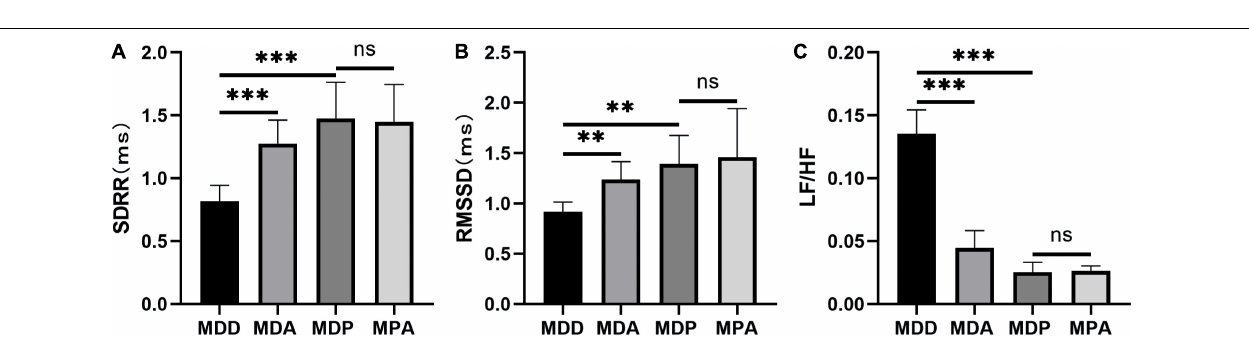
FIGURE 12 | Behavioral measurements. (A) Sucrose preference after CUMS. (B) Immobility time after CUMS. *** p < 0.001 vs. MDD; ns, no significance.